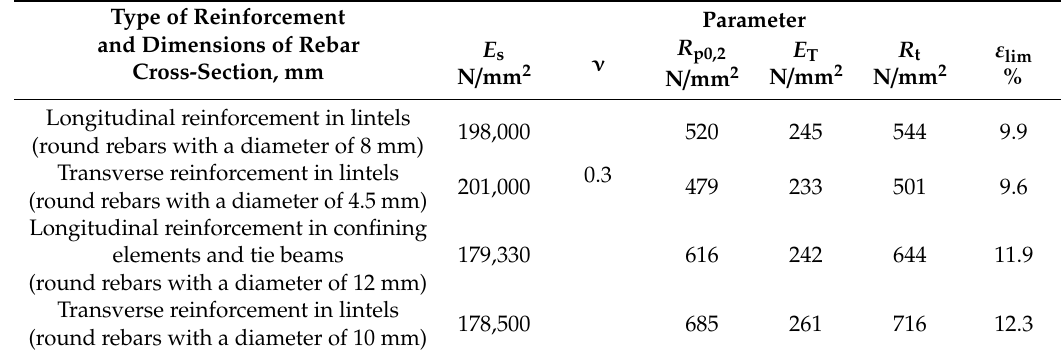
Table 7. Mechanical parameters of concrete steel used in the numerical